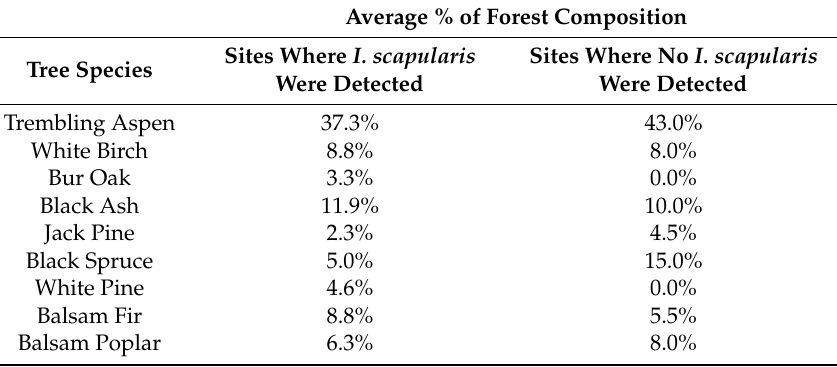
Table A1. Average forest composition of active surveillance sites in the NWHU catchment area,